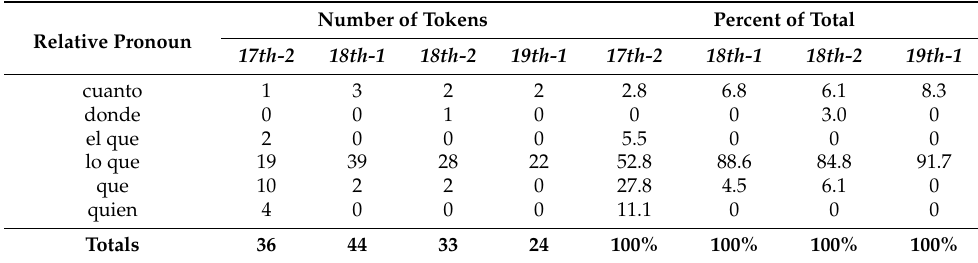
Table 4. Relative pronouns in Corpus 2 by time